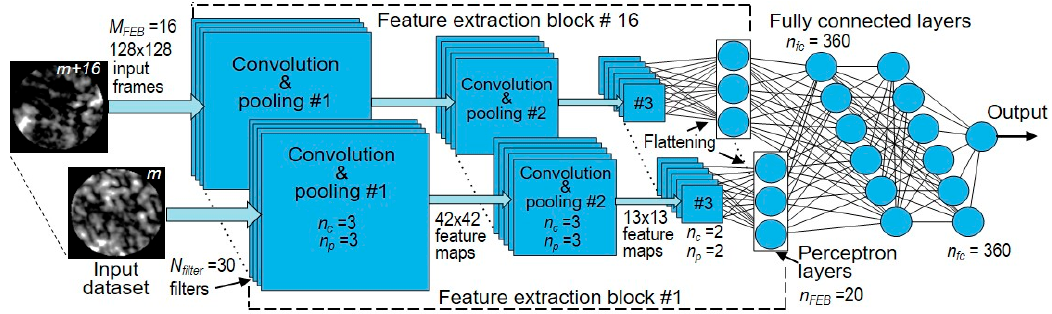
C prediction based on DNN-processing of short- n